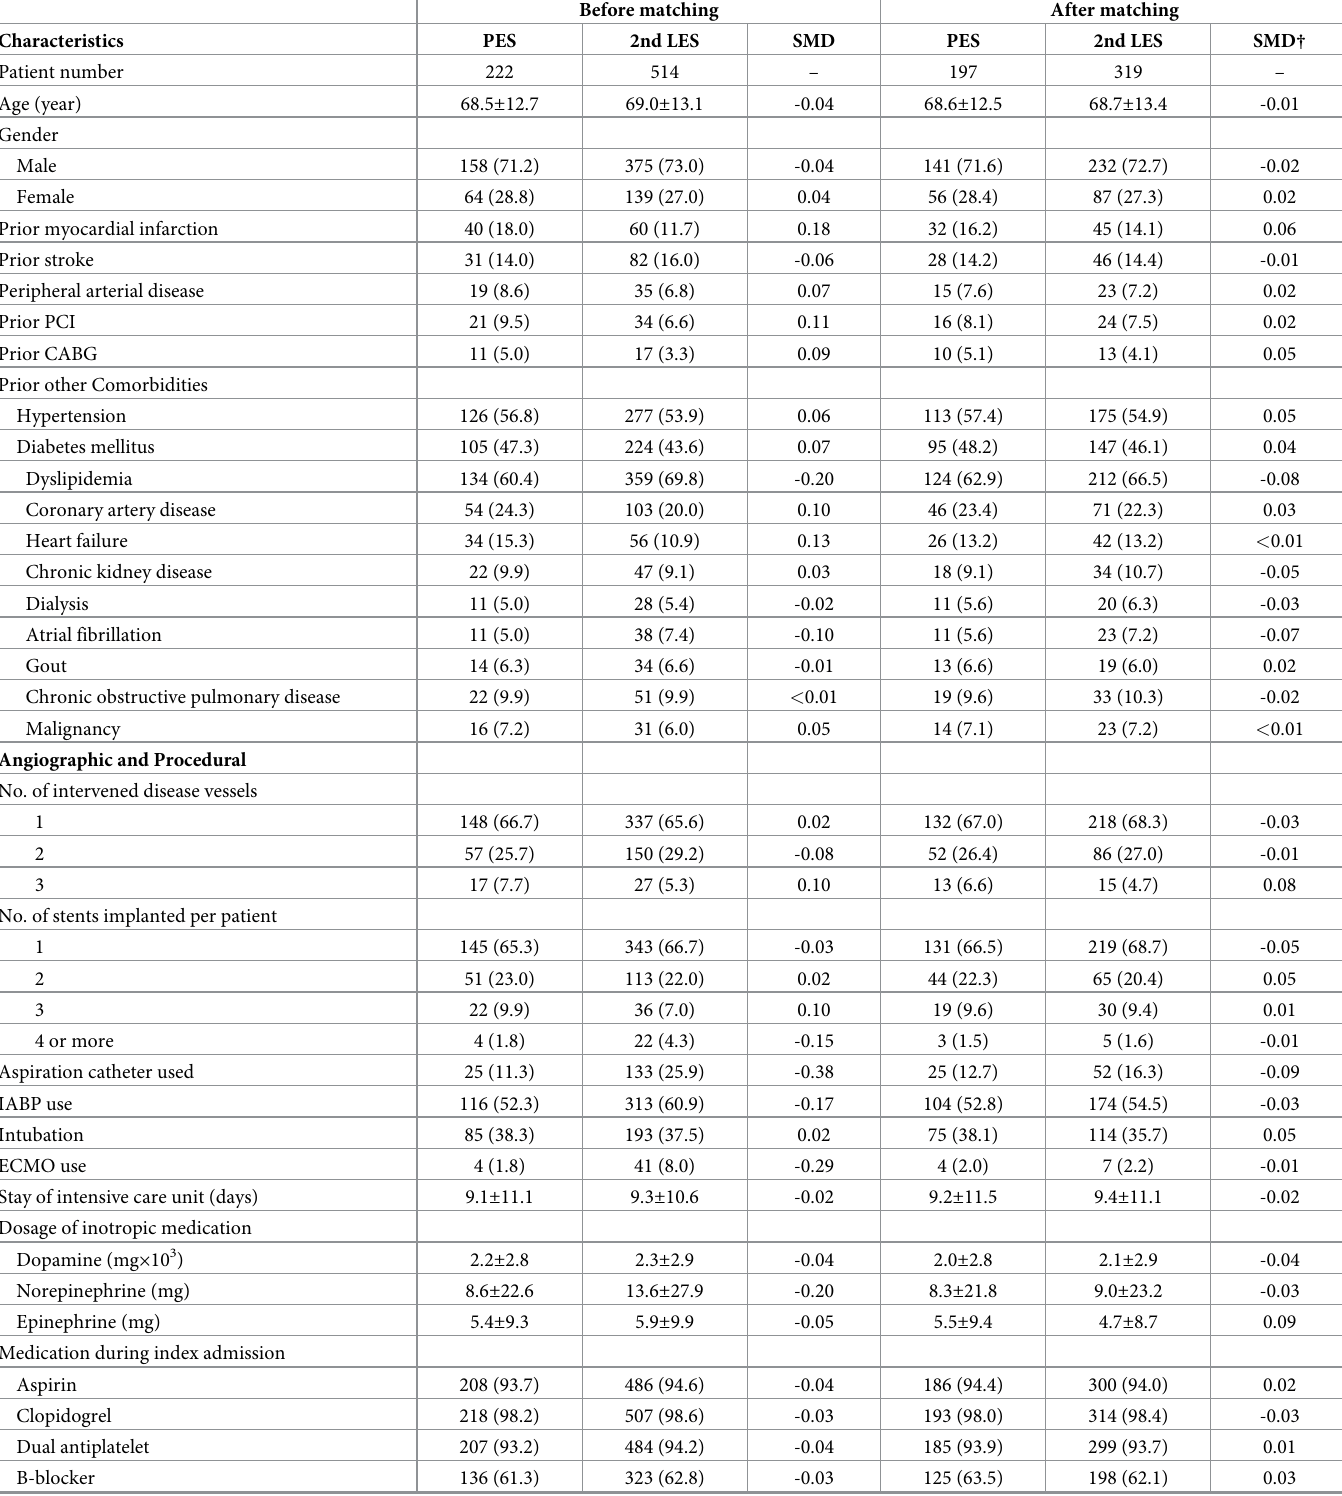
Table 1. Baseline characteristics of the patients.